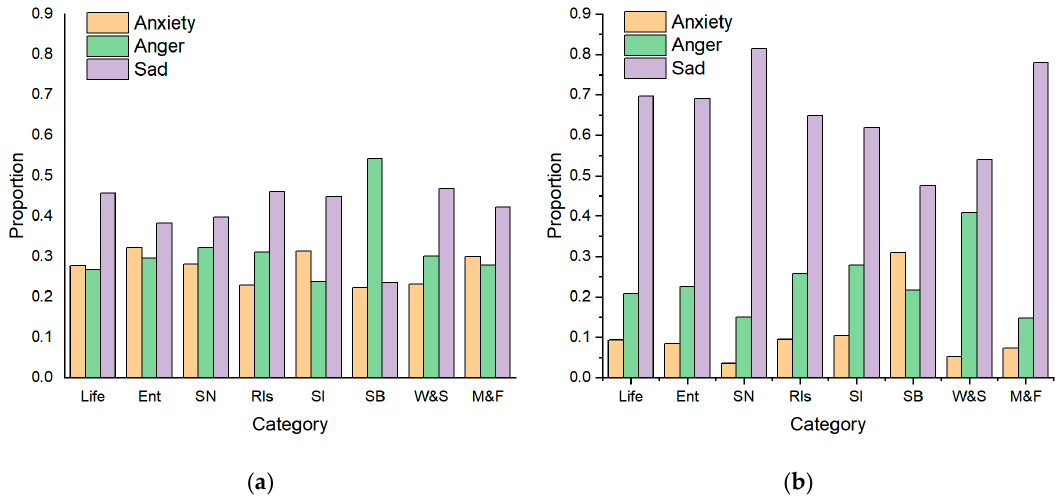
Figure 5. Negative emotion distribution of ( a ) Chinese and ( b ) English topic data.